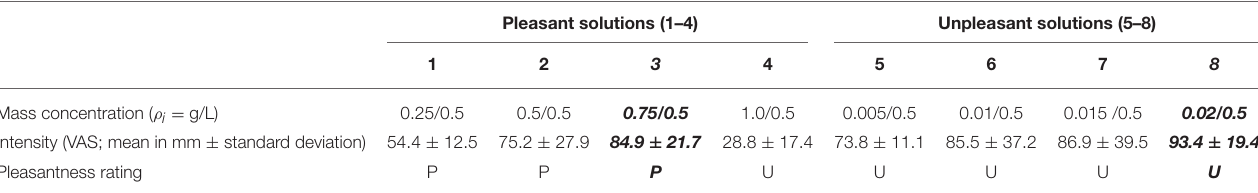
TABLE 1 | Results of the pilot